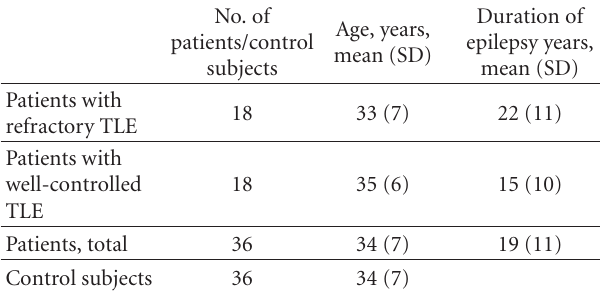
Table 1: Demographics of the study patients and the control